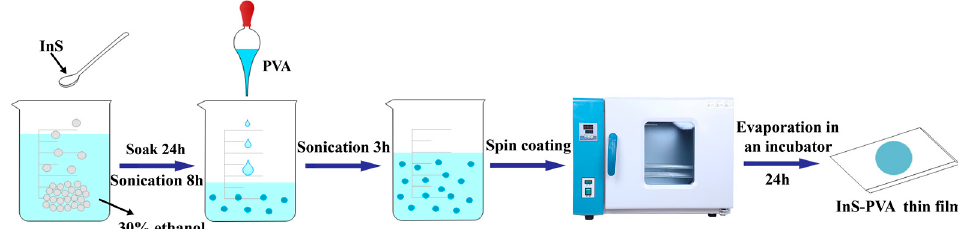
Figure 1. Fabrication process of an indium monosulfide-polyvinyl alcohol (InS-PVA) thin film saturable absorber (SA).